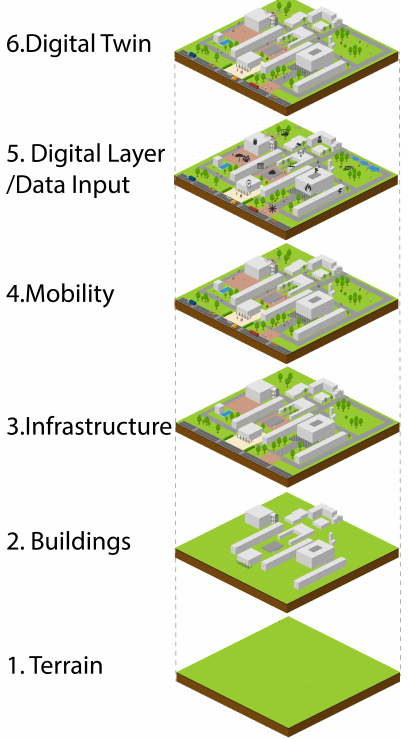
Figure 6. Smart city digital twin layers of integration